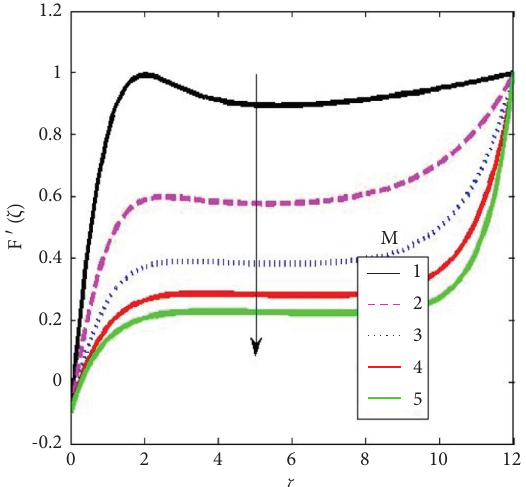
Figure 4: Efect of magnetic parameter on the velocity distributions.